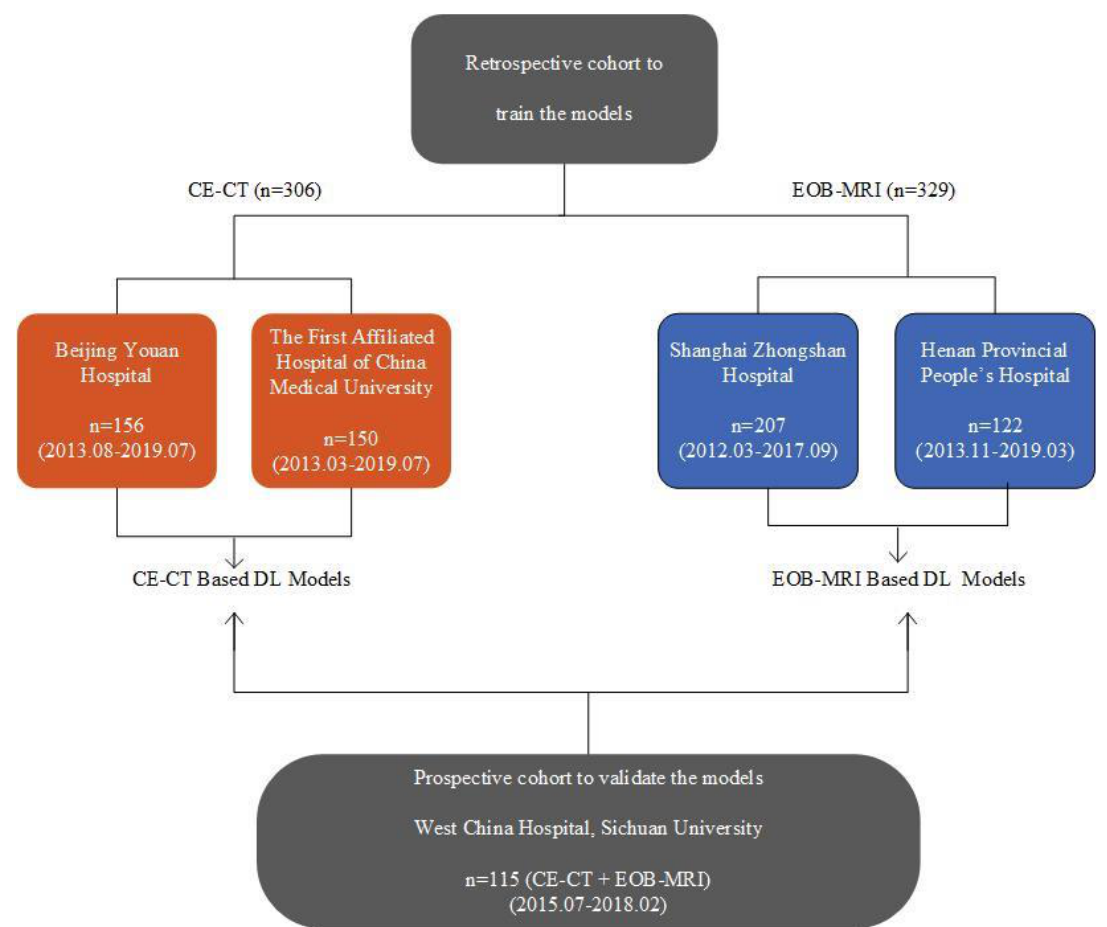
Figure 1. Distribution of the enrolled cohorts. The collected cohorts included two retrospective training cohorts ( n = 635) and one external prospective validation cohort ( n = 115). The retrospective training cohort for CE-CT based models was collected from Beijing Youan Hospital ( n = 156) and the first affiliated hospital of China Medical University ( n = 150); for EOB-MRI-based model training, it was collected from Shanghai Zhongshan Hospital ( n = 207) and Henan Provincial People’s Hospital ( n = 122). The prospective cohort contained 115 patients who underwent both CE-CT and EOB-MRI. The validation cohort was used for model validation, as well as the head-to-head comparison.